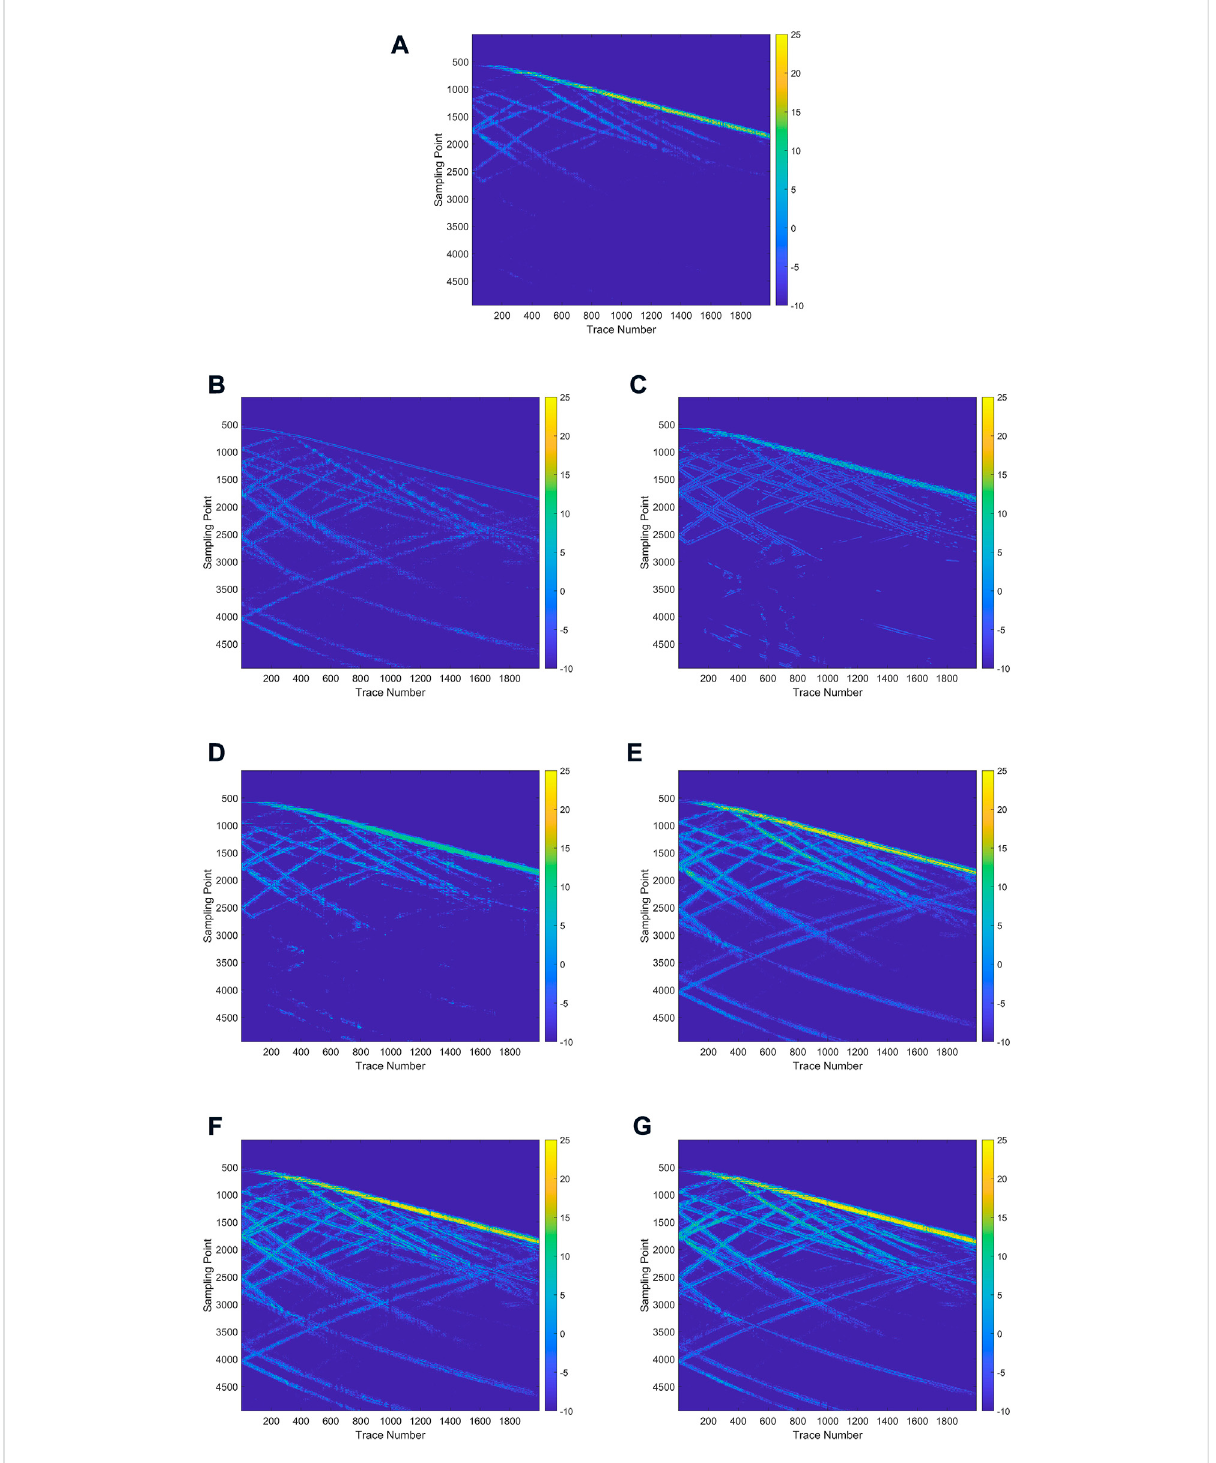
FIGURE 8 Local SNR analysis. (A) Local SNR of the synthetic noisy DAS-VSP data. (B – G) Local SNR of the denoised result of Band-pass fi ltering, Wavelet transform fi ltering, WNNM, DnCNN, U-Net, MSI-Net,